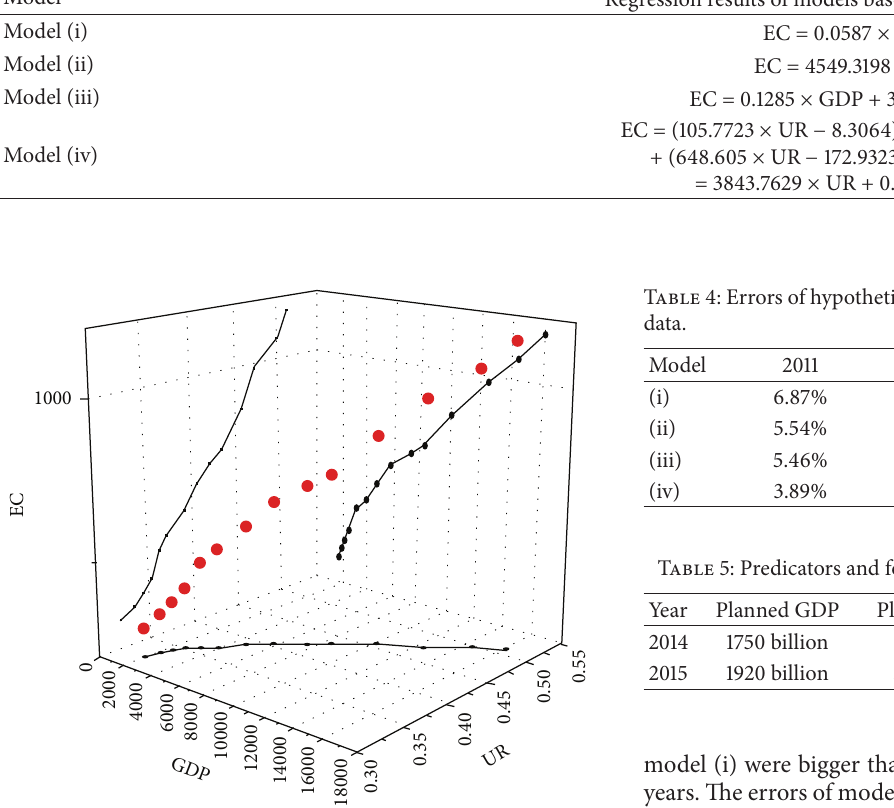
Figure6:3DscatterplotandthreeprojectionlinesamongGDP,UR, and EC.